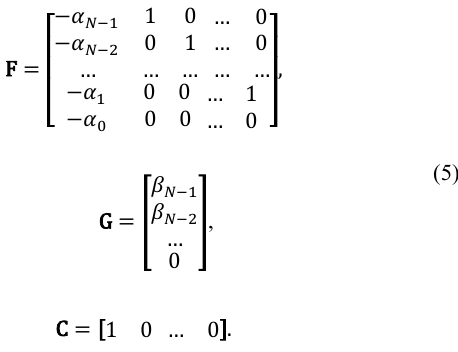
Figure 1. Representation of linear dynamic